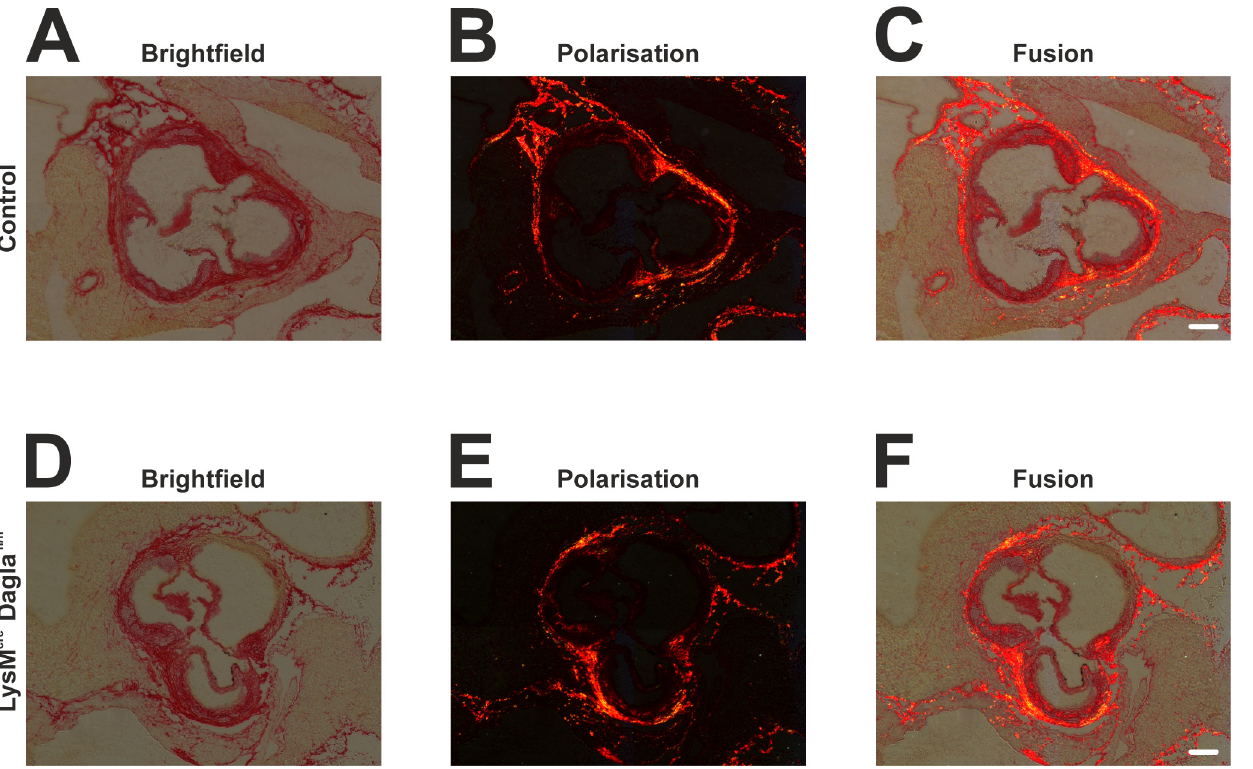
Fig 2. Collagen structures within the atherosclerotic aortic sinus. Frozen sections of both control mice and Dagla-deficient mice were stained using haematoxylin and direct red to visualise collagen structures. Microphotographic pictures were taken using bright field microscopy (A, D), polarisation microscopy (B, E), or a combination of both (C, F). No differences were seen in amount and distribution of collagen fibers between control mice (A-C) and Dagla-deficient mice (D-F). Scale bar, 200 μ m. Cre, cyclisation recombination; Dagla, diacylglycerol lipase α ; fl, flanked by